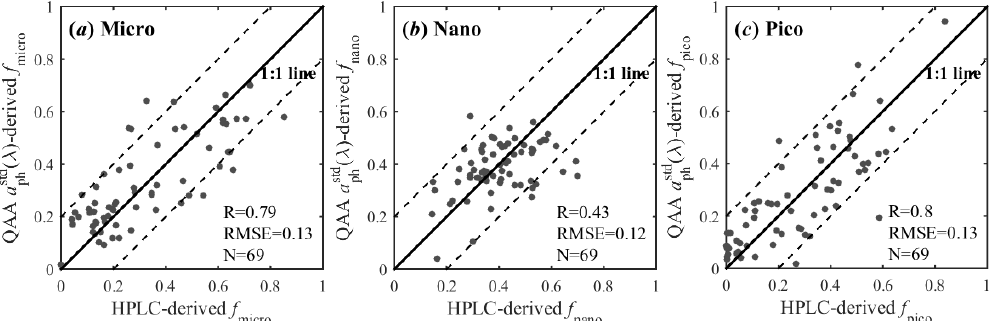
Figure 5. Comparisons of the PSC modeled using a ph derived from R rs with the HPLC-derived values for micro- (a) , nano- (b) , and pico- phytoplankton (c)